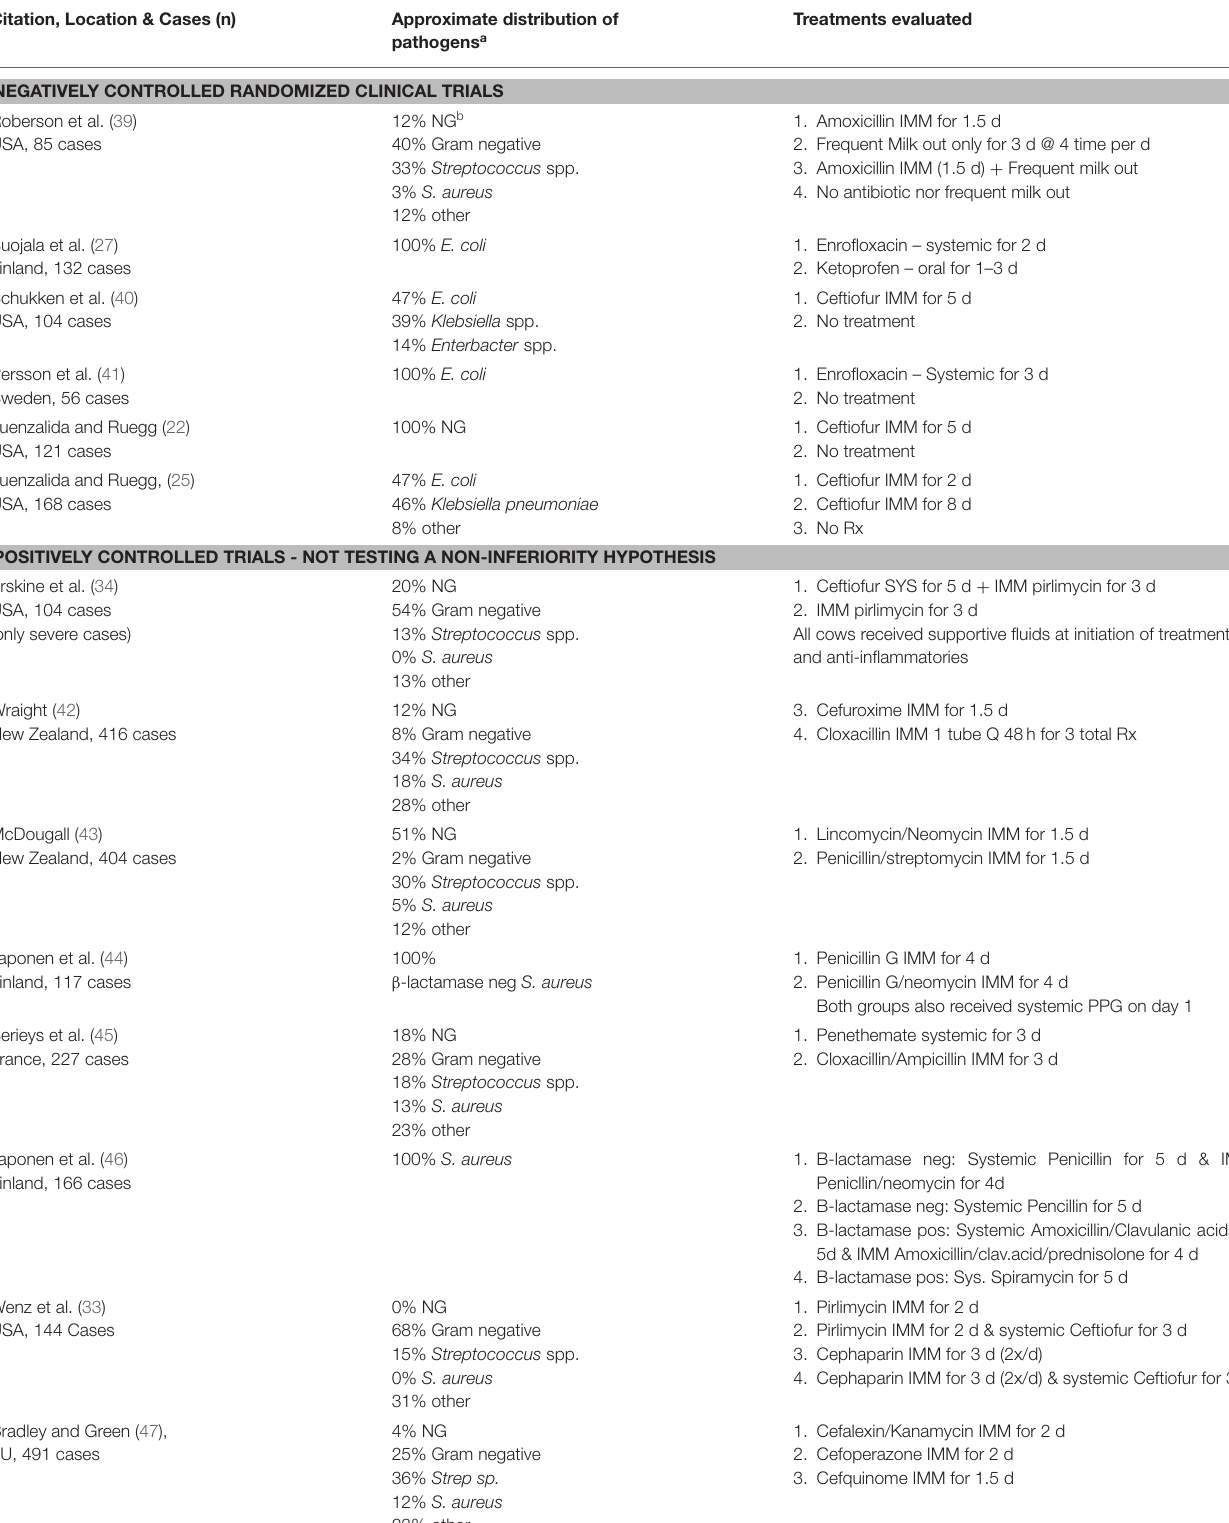
TABLE 1 | Description of 26 clinical mastitis treatment trials published since 2000 and meeting inclusion criteria for this